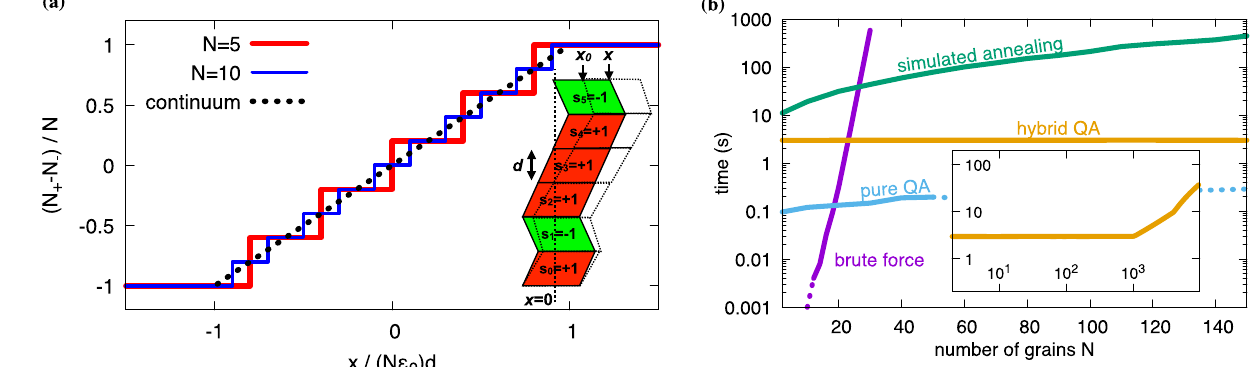
Figure 1. Results of the one-dimensional model comparing different numerical and analytical methods. )/ N as function of the displacement x / dN ε 0 . Comparison between N ( a ) Mean variant orientation ( N + − − the results obtained by numerical minimization (solid lines) versus the analytical theory for an infinite and continuous system (dashed line). For large displacement, all “spins” are aligned and therefore the “magnetization” saturates. The inset shows a sketch of the one-dimensional arrangement of martensite variants 1 (red) and s 1 (green). The bottom row is fixed to position x 0 , whereas the top grain has a mean s i i = − = + = position x 0 in the stress free state. If an additional external stress or strain is applied, the top layer is moved to position x , and the entire microstructure is sheared to the dashed configuration. ( b ) Elapsed computation time as a function of the number of grains. Different methods and algorithms are compared. Dashed parts of the QA curve belong to the regime of chain breaks. For large system sizes, only the hybrid quantum annealing approach remains feasible, showing an almost constant computing time need for less than 1000 spin variables